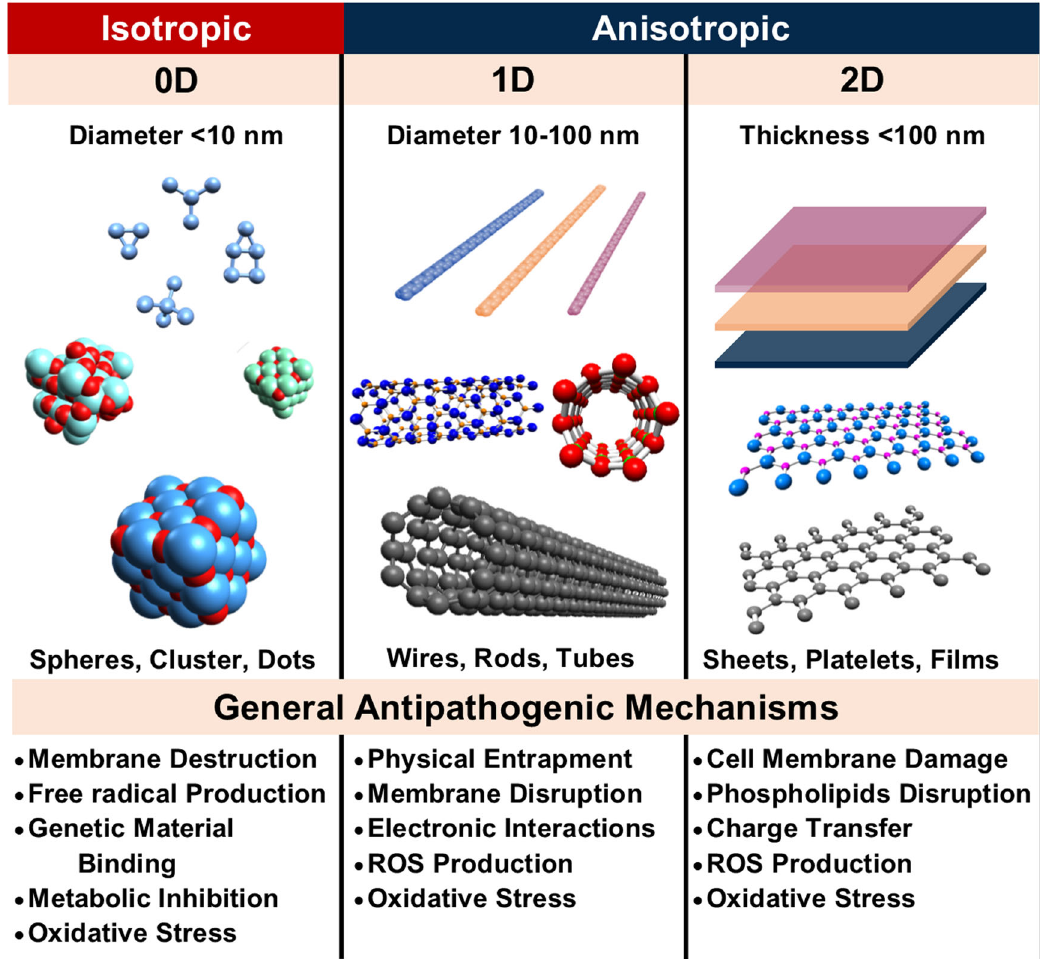
Fig. 1 The contrast of 0D, 1D and 2D materials. Common structures for each dimensional classi fi cation and their general antimicrobial